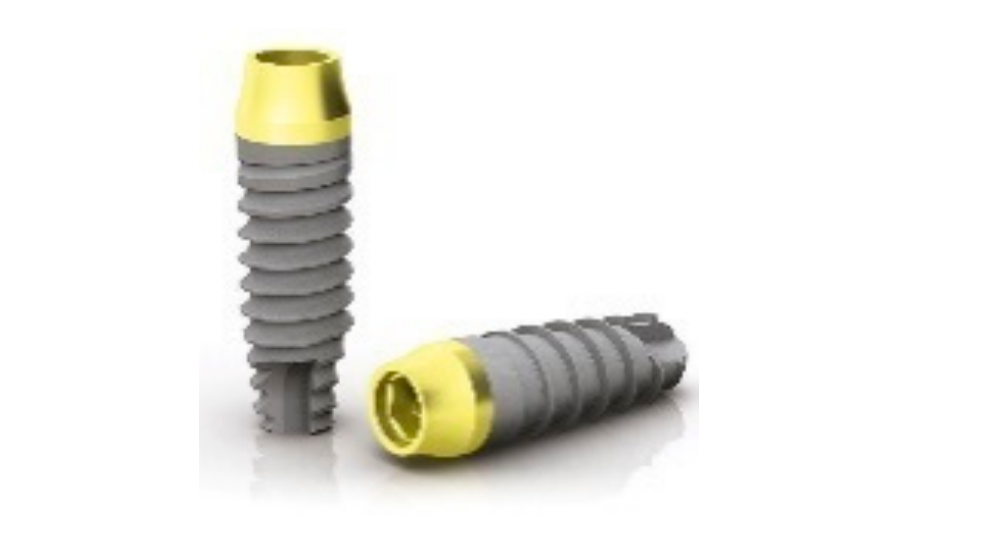
Figure 2. Prima implants (Sweden and Martina).